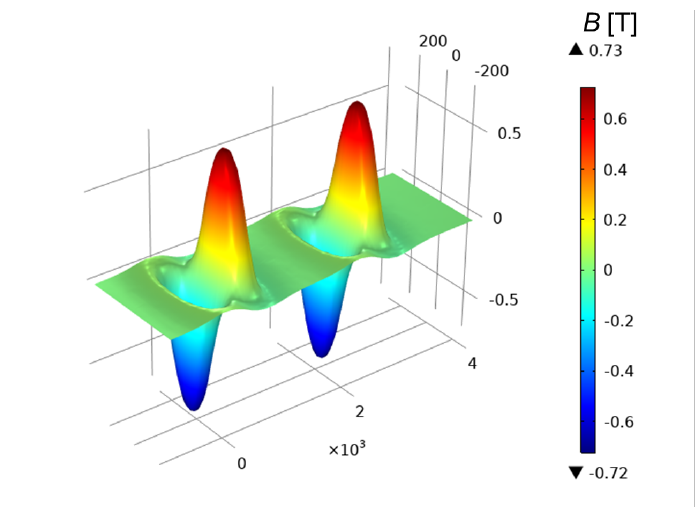
Figure 4. Axial B distribution on the surface 90-mm from the bottom surface of the HTS coils